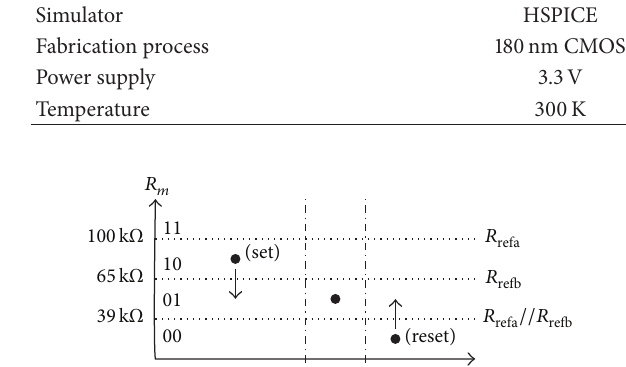
Table 3: Simulation condition.